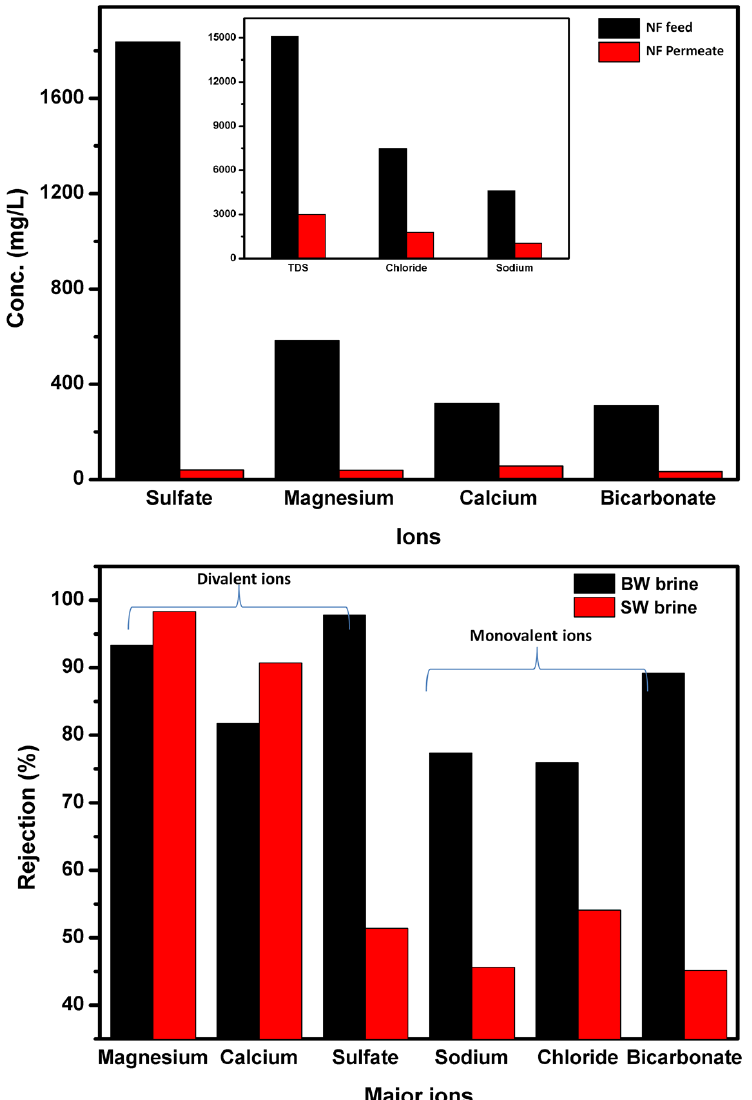
Figure 3. Removal of divalent and monovalent ions from BWRO and SWRO brines using the membrane operating conditions: pressure 0.7 MPa, operation time 8 h, operation temperature, 25 °C & flow rate, 5 L/min.